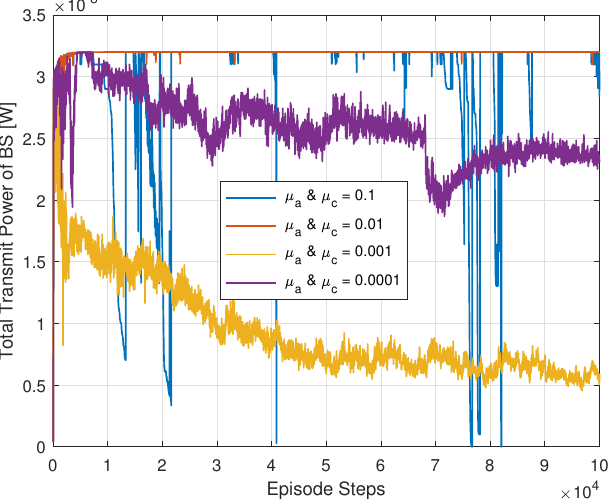
Figure 9. Total transmit power of BS versus episode steps under different learning rates.